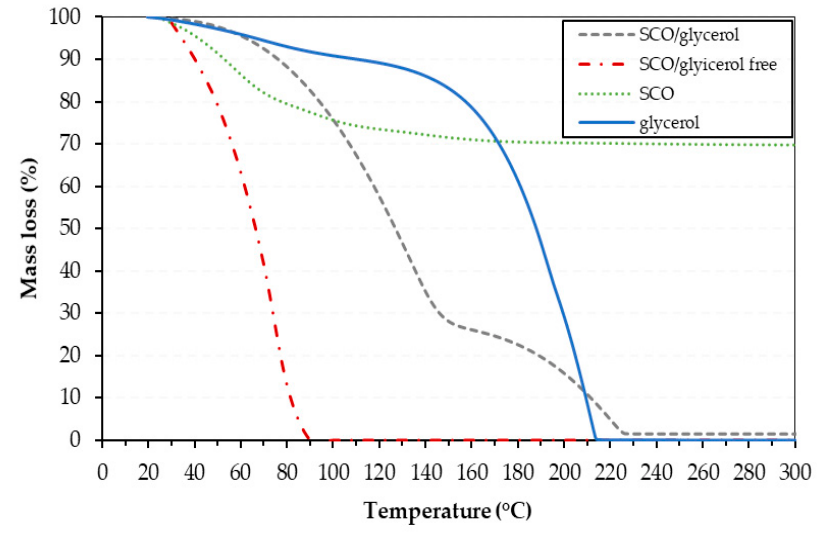
Figure 6. Thermogravimetric curves (TG) curves of studied samples.